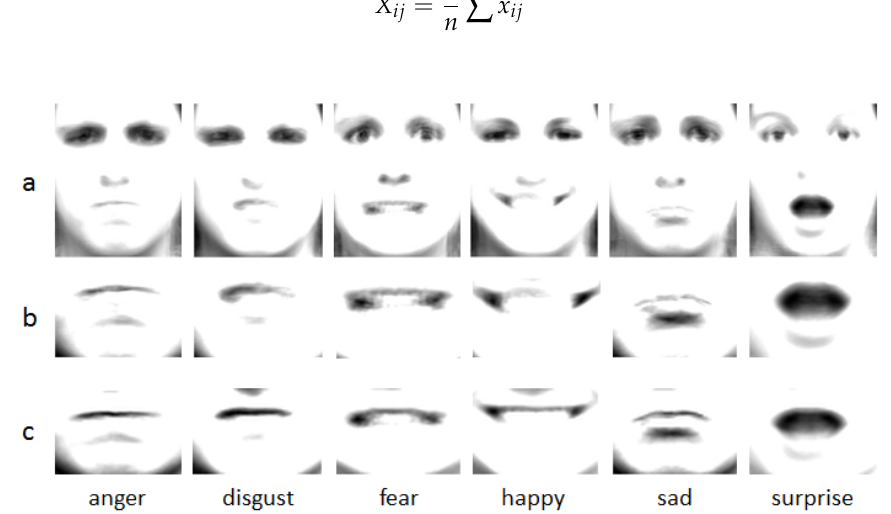
Figure 3. Average faces and the average salient areas. ( a ) Average faces of the six expressions; ( b ) Mouth areas of the average faces; ( c ) Average salient mouth